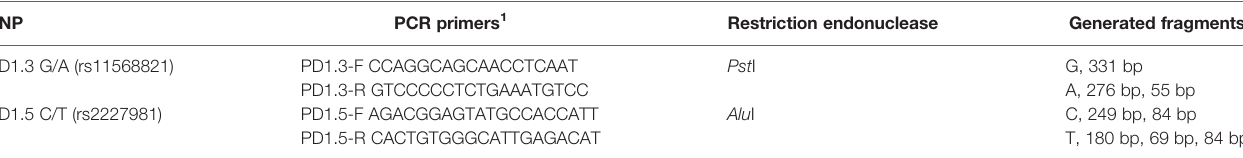
TABLE 2 | Analysis of the PD1 SNP polymorphisms by